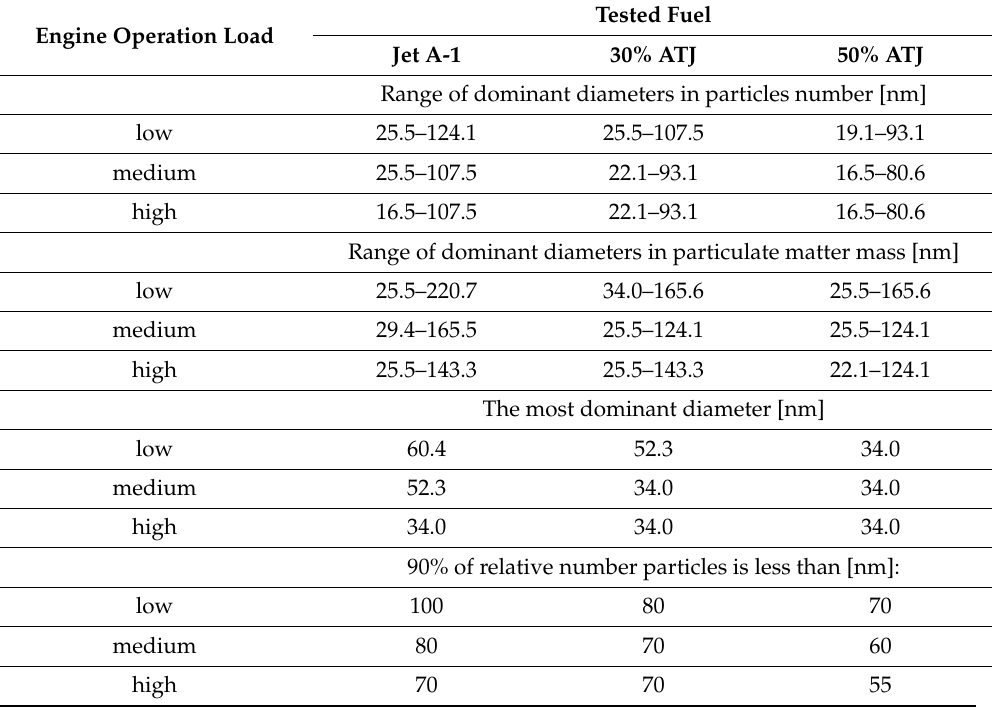
Table 7. Main results from researches depending on tested fuel and engine operation